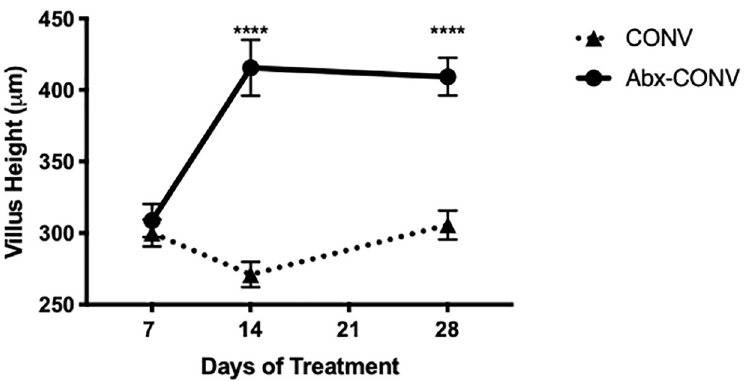
Fig 4. Optimal timing of antibiotic therapy necessary to induce intestinal mucosal growth. Abx-CONV mice were treated for a duration of 1 (n = 6), 2 (n = 6), and 4 (n = 9) weeks. Intestinal mucosal changes are observed only after 2–4 weeks of enteral antibiotic therapy. Values presented as Mean ± SEM, ���� p < 0.0001.